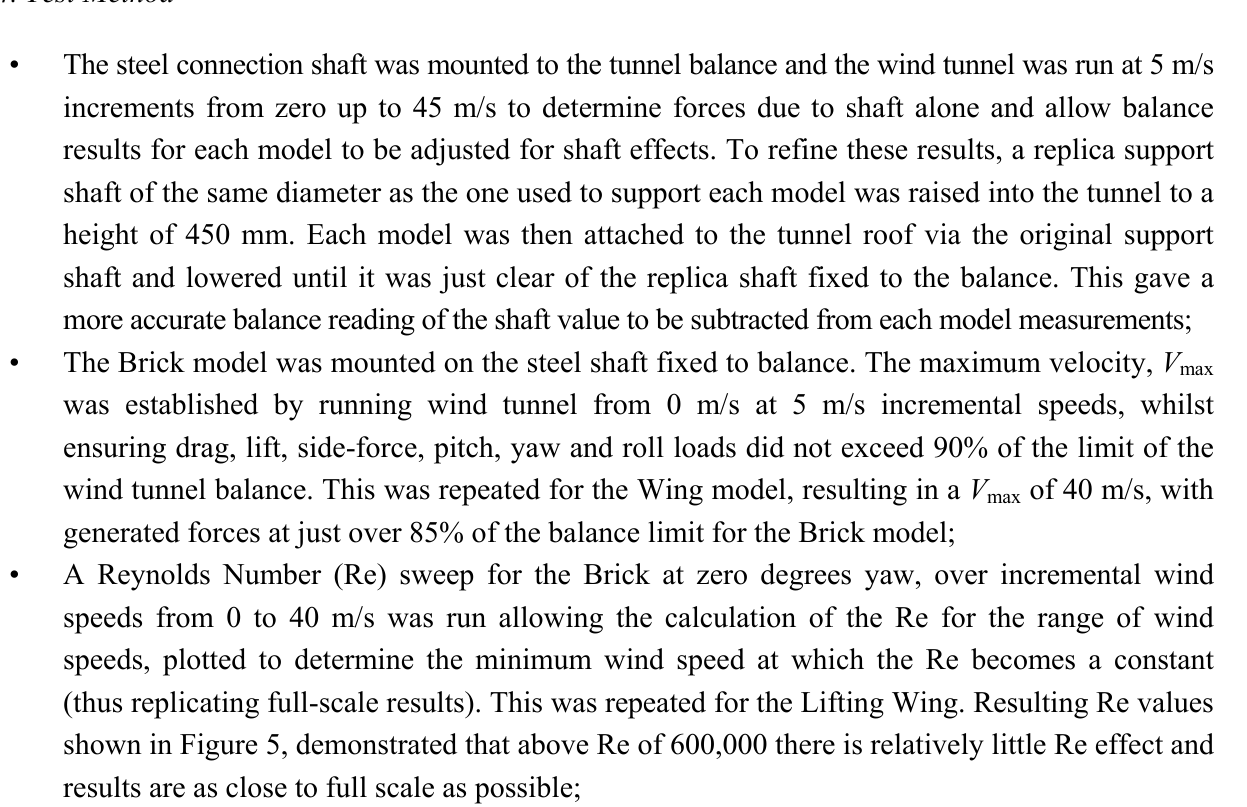
Angle versus CPitch for 30 m/s and 40